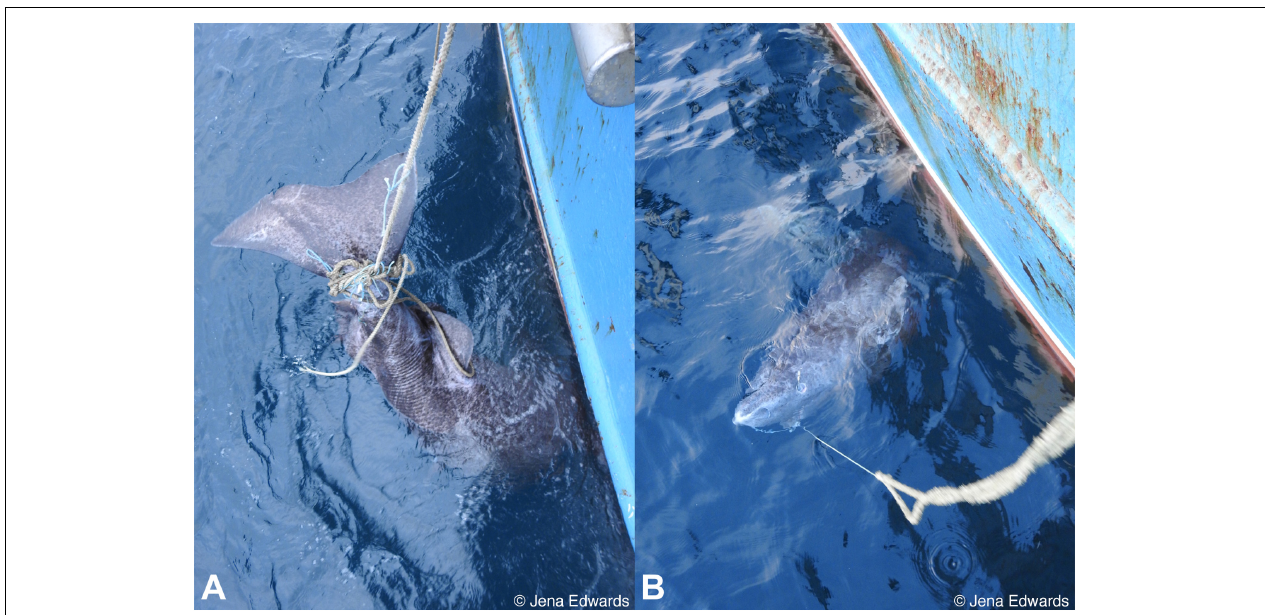
FIGURE 5 | Incidental capture of Greenland sharks via scientific bottom longline. (A) Shark entangled in mainline around caudle peduncle. (B) Shark hooked by mouth (photos Jena Edwards).